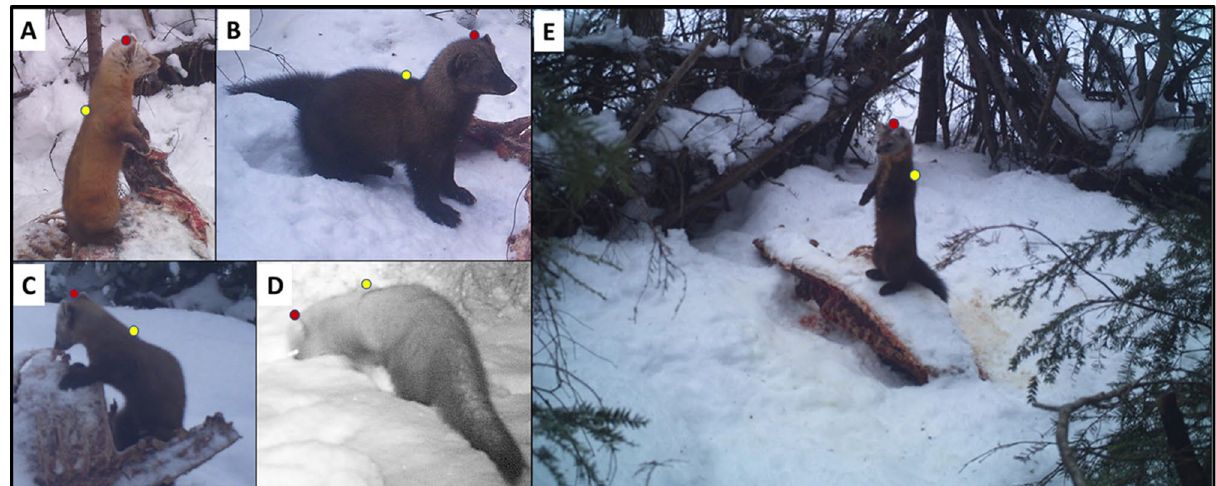
Figure 5. Behavioral classifications of American martens and fishers as examples of ( A ) vigilant marten, ( B ) vigilant fisher, ( C ) feeding marten, ( D ) non-vigilant fisher, and ( E ) vigilant marten at site with partial white- tailed deer carcass and brush enclosure visible. Red and yellow dots represent the top of the head and top of the shoulders, respectively, used to assess vigilance posture in non-feeding animals. Upper Peninsula of Michigan, USA, 2017–2019 (image credit: J.